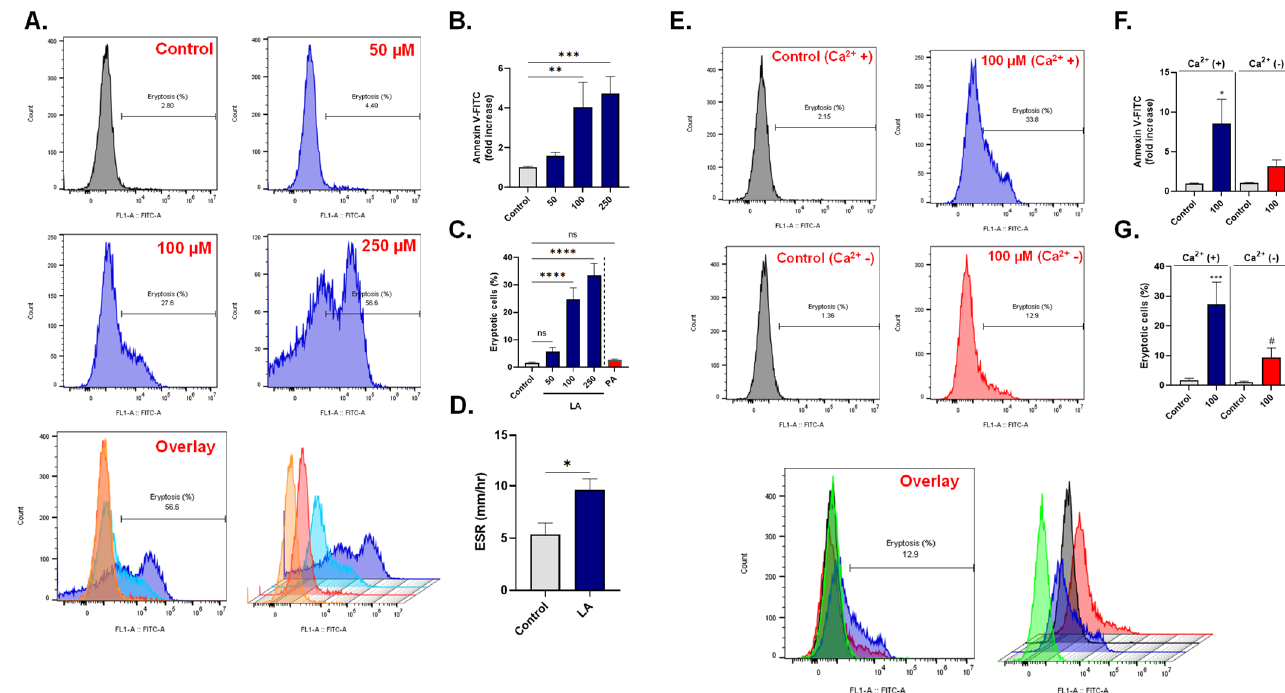
Figure 2. LA elicits Ca 2+ -dependent PS exposure. ( A ) Representative histograms of Annexin V-FITC of cells exposed to 0–250 µ M of LA. ( B ) LA-induced fold increase in mean intensity fluorescence (MFI) of Annexin V-FITC. ( C ) LA but not PA induces an increase in the percentage of Annexin V-positive cells. ( D ) LA-induced increase in ESR. ( E ) Representative histograms of Annexin V-FITC of cells exposed to 0–100 μ M of LA with and without Ca 2+ . ( F ) LA-induced fold increase in MFI of Annexin V-FITC with and without Ca 2+ . ( G ) LA-induced fold increase in the percentage of Annexin V-positive cells with and without Ca 2+ . ns not significant, * ( p < 0.05), ** ( p < 0.01), *** ( p < 0.001), and **** ( p < 0.0001) indicate significantly different values from control conditions whereas # ( p < 0.05) indicate statistical significance compared to LA-treated cells.